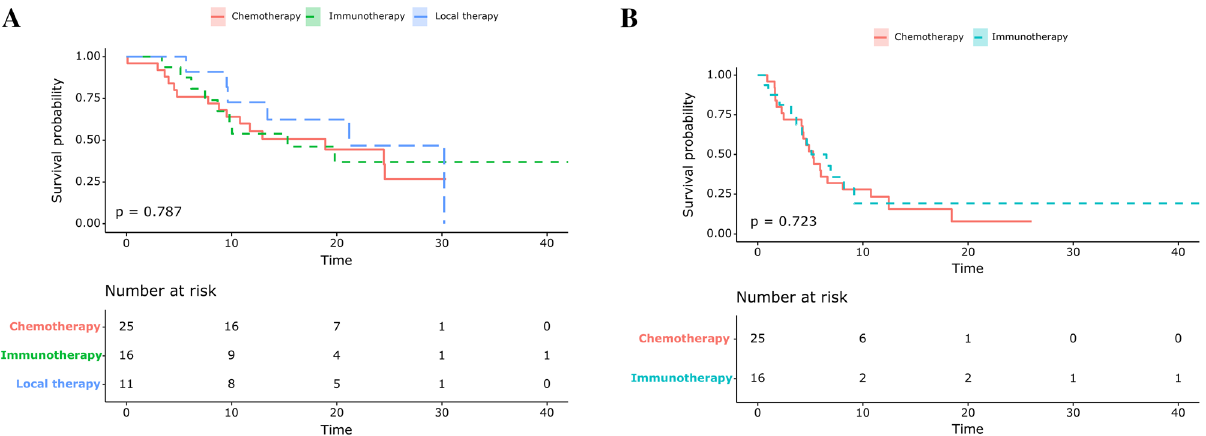
Figure 3. Kaplan–Meier survival curves showing ( A ) overall survival from the point of acquired resistance based on the subgroups of subsequent treatment ( B ) progression free survival based on the subsequent